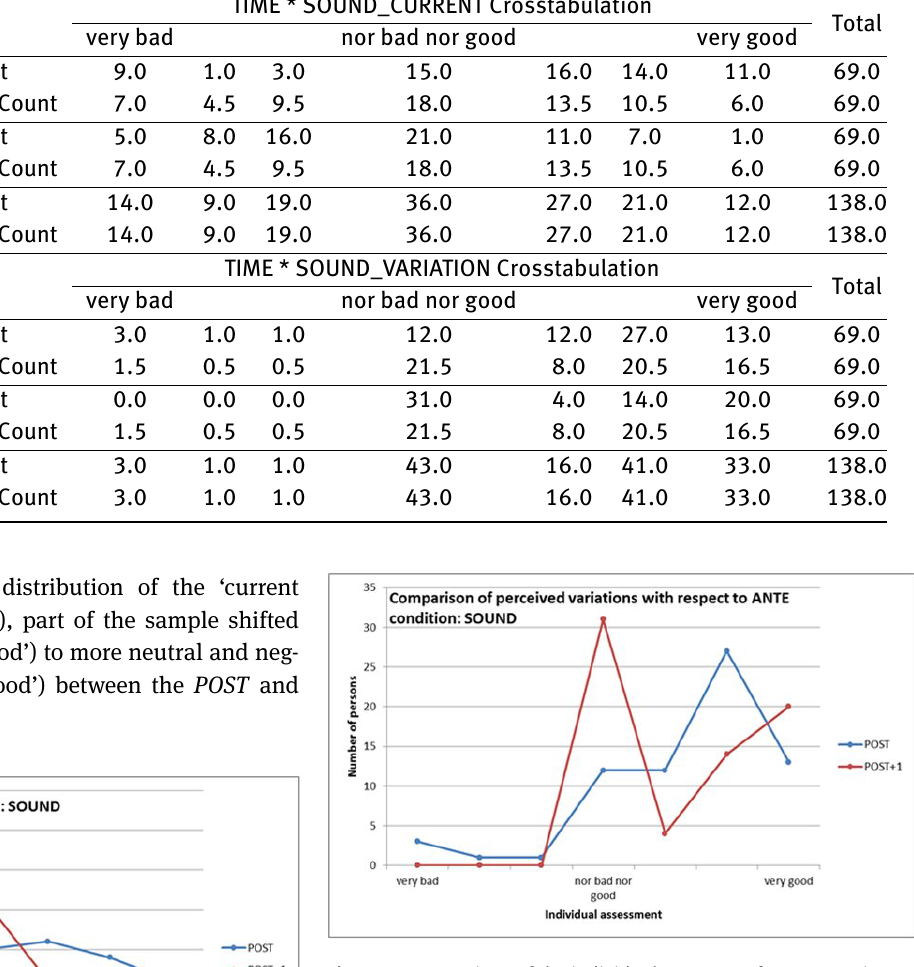
Figure 9: Comparison of the individual responses for Q2 over time (SOUND